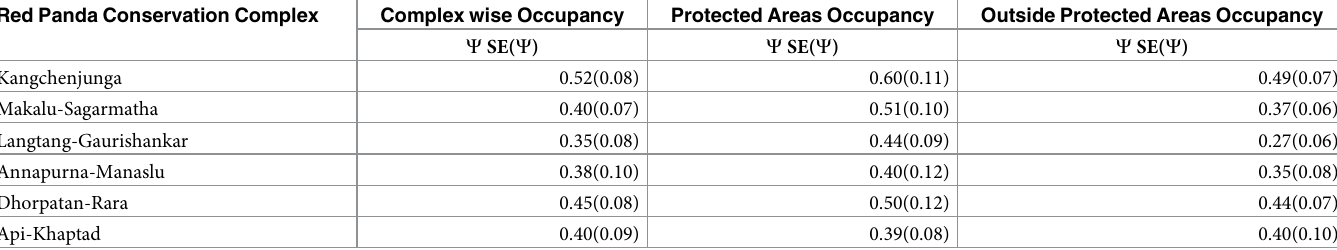
Table 5. Comparison of red panda occupancy estimates ( C , SE( C )) based on top model in six conservation complexes, protected areas, and outside protected area of Nepal [6]. Red Panda Conservation